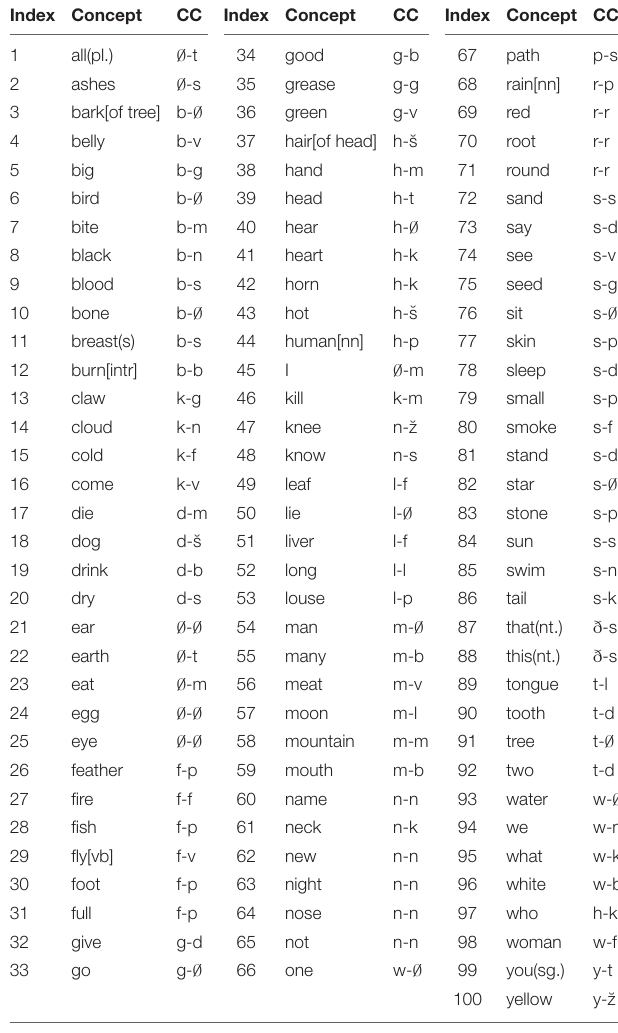
TABLE 4 | Word-initial consonant correspondences (CCs) between English (left) and French (right) (extracted from Ringe,